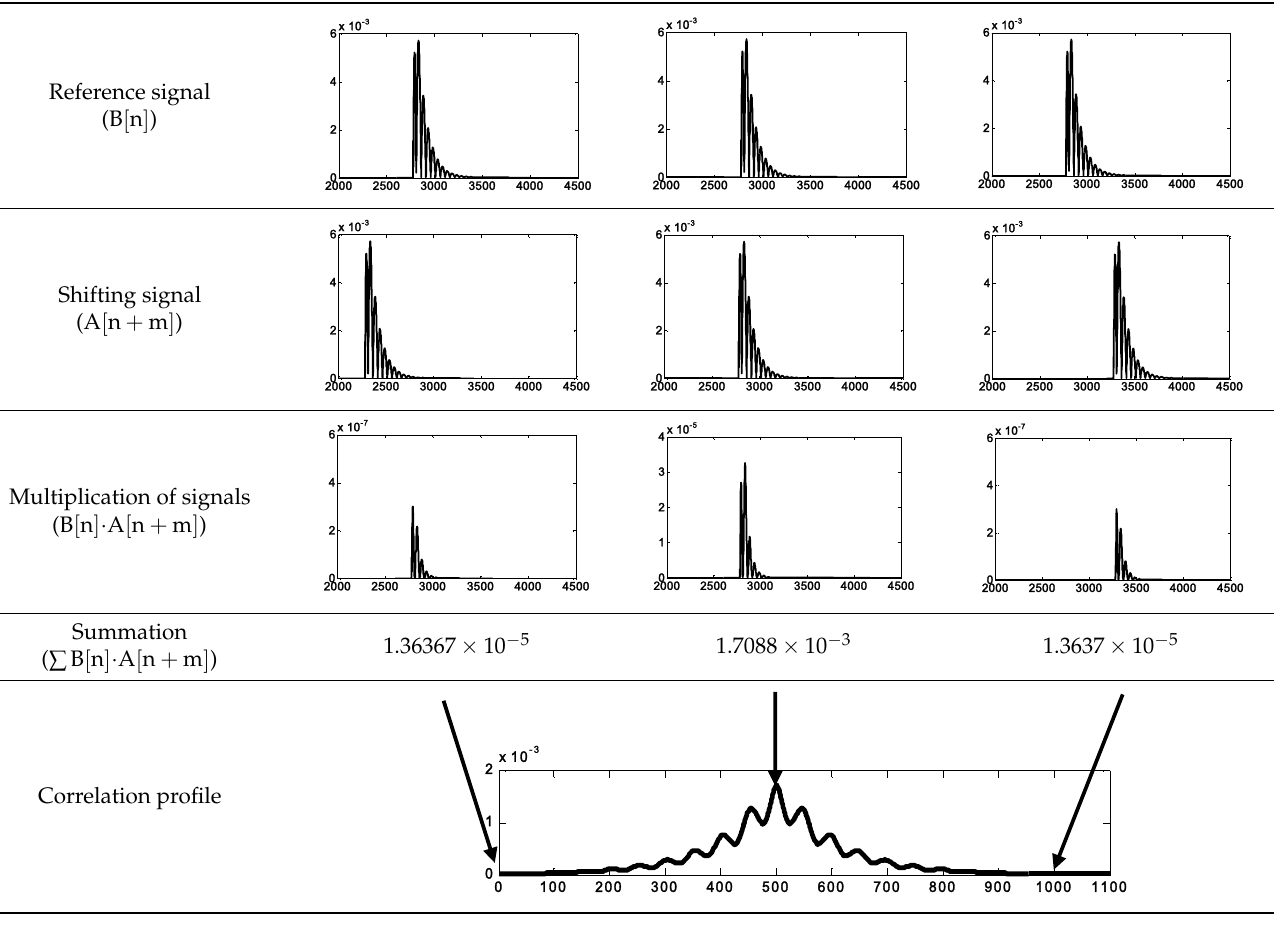
Table 2. Segmented correlation process.